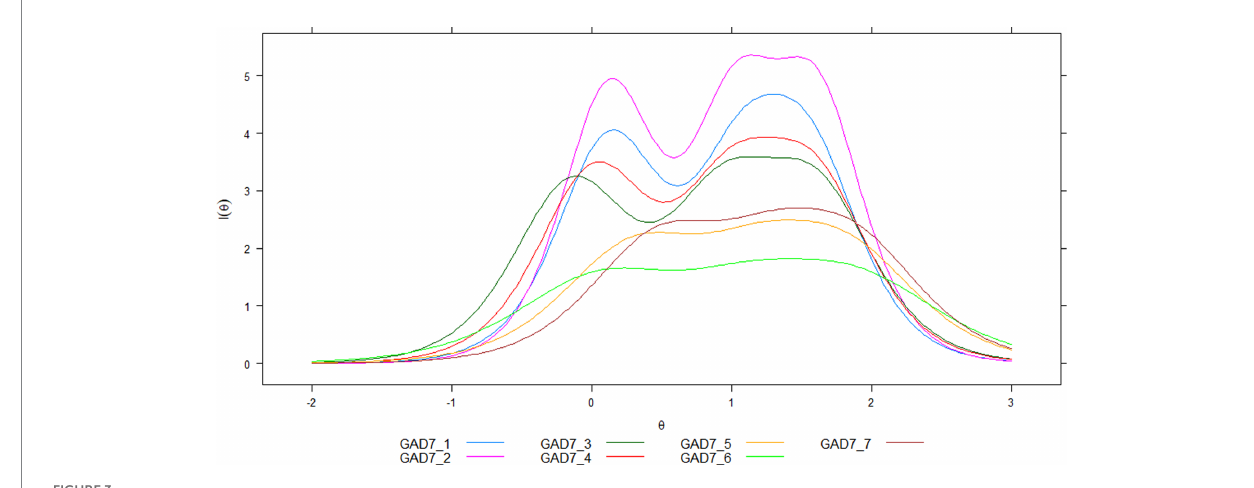
FIGURE 3 Item information curves for